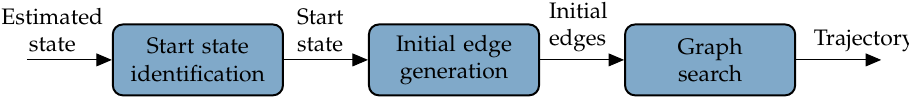
Figure 3. Framework of the proposed approach for the generation of the initial